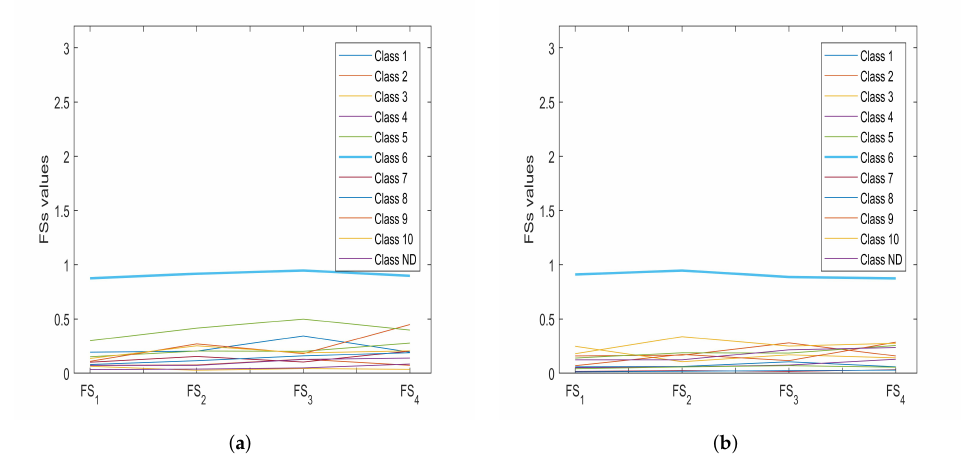
Figure 9. Classification example related to the EC maps in Figures 6a and 10b from which it is easy to deduce that the belonging class of the analyzed maps is the sixth.